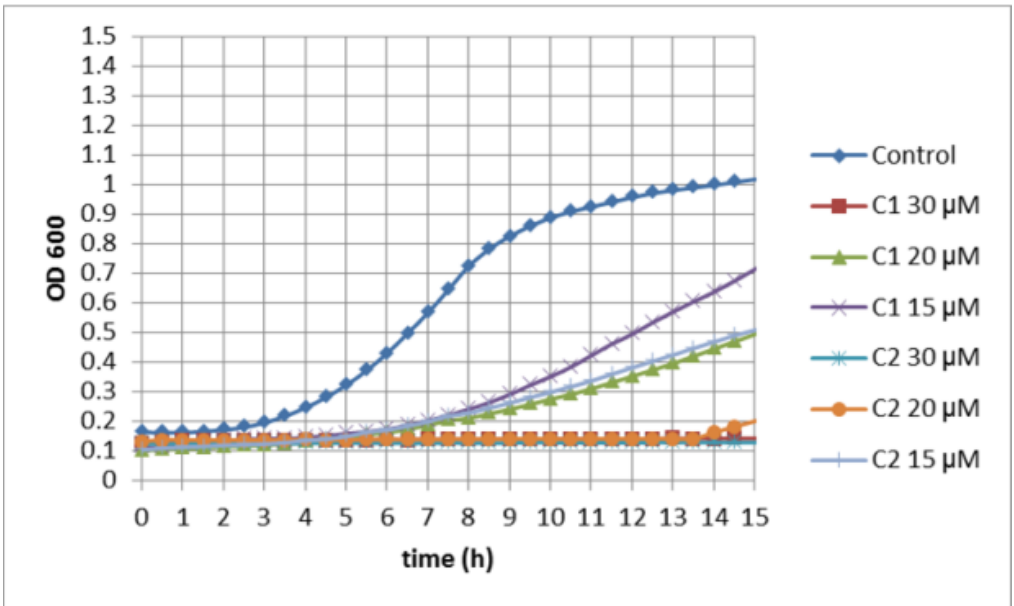
Figure 2. Effects of various concentrations of two selenocyanates on the growth in shake culture of wt BY4742. The experiment was carried out in triplicates and repeated twice with similar results. C1 — Compound 1 and C2 — Compound 2 .